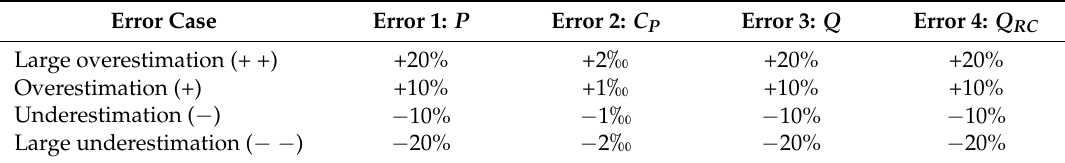
Table 2. Overview of the four observation errors and their magnitudes.